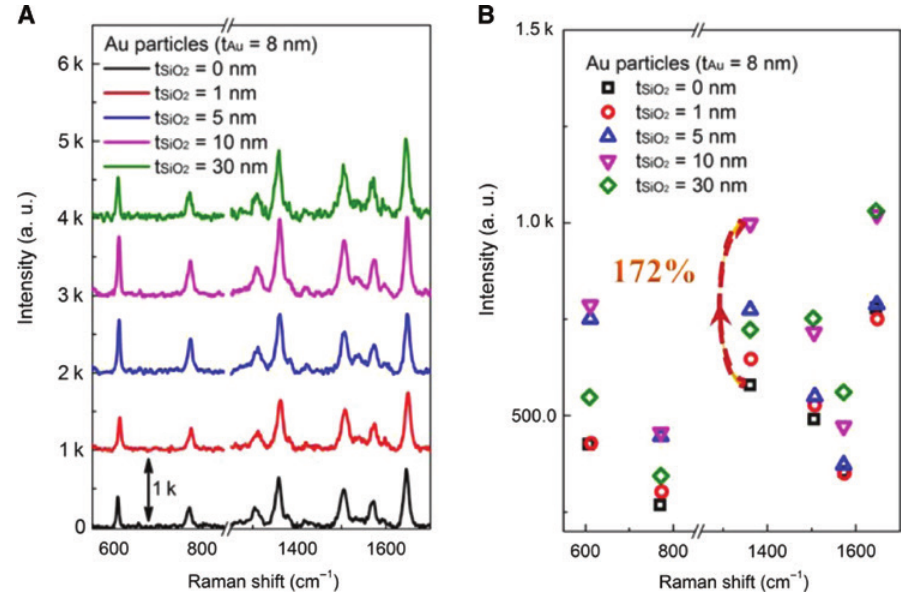
Figure 7: Surface-enhanced Raman scattering SERS performance for the Au particles based substrate. (A) SERS spectral properties of the Au particles under a tuning thickness of silica buffer layers. (B) The plotted intensity spectrum of the Raman modes as a function of the silica layer’s thickness. The dashed red arrow indicates a 172% enhancement factor for the 10-nm-thick silica insulated Au particles to that of the Au particles structure without the silica